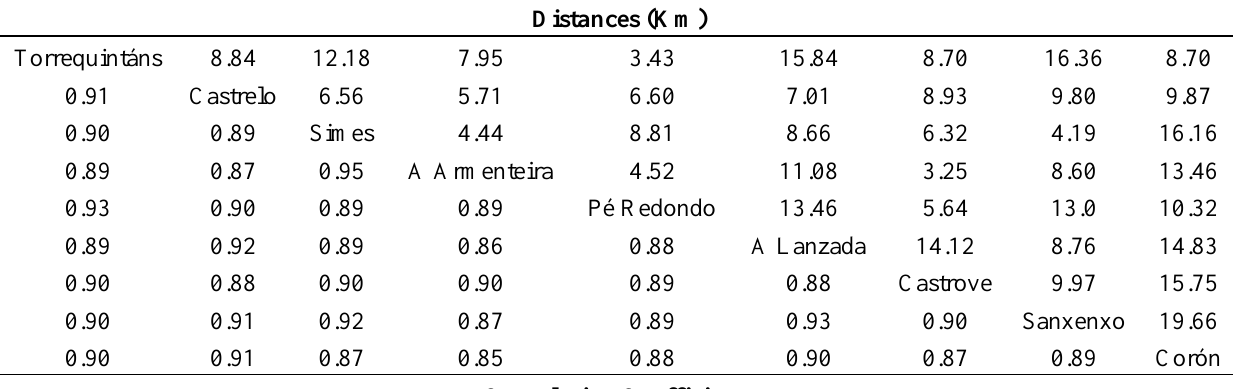
Table 1. Distances among the studied stations (km) and correlation coefficients (CC).